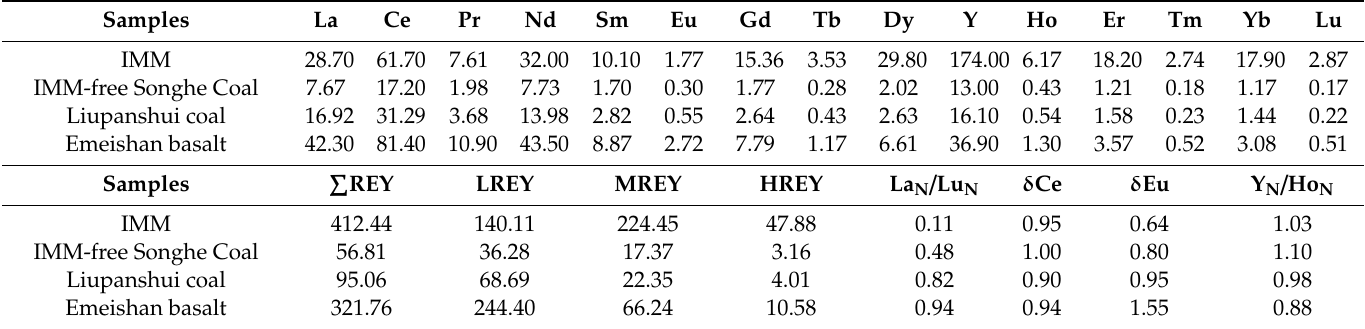
Table 2. Rare earth elements concentration and characteristic values of the IMM of fracture- structural coal, the IMM-free Songhe coal, the Liupanshui coal and the Emeishan basalt, Western Guizhou, Southwestern China ( µ g / g).